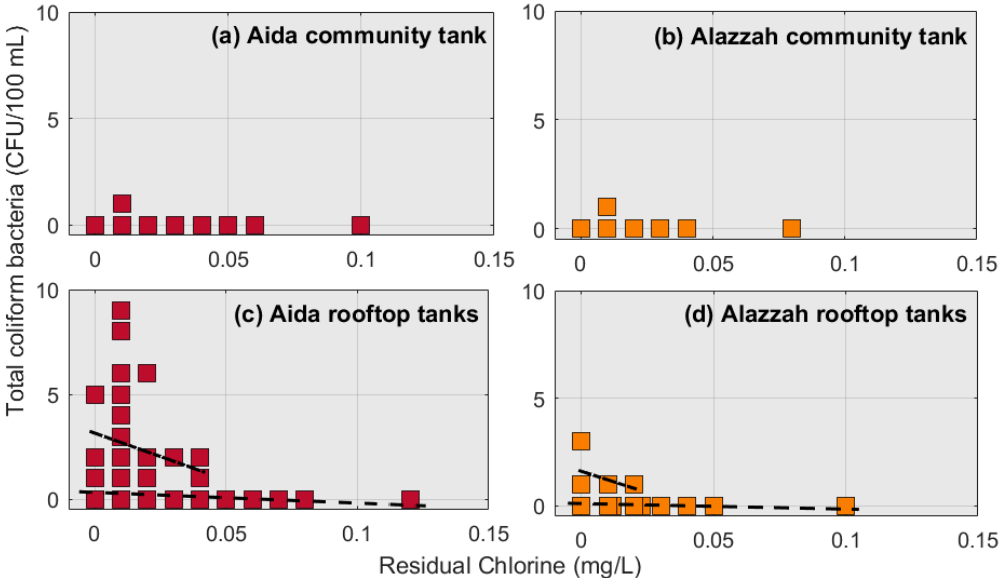
Figure A2. Relationship between bacteria levels (CFU concentrations) and residual free chlorine concentrations in ( a , b ) community- and ( c , d ) rooftop-tank water samples from Aida Camp and Alazzah Camp. Regression lines through all the data are shown with coarsely-dashed lines; regression lines through all the non-zero bacteria data are shown with finely-dashed lines. See Table A1 for summary statistics. .